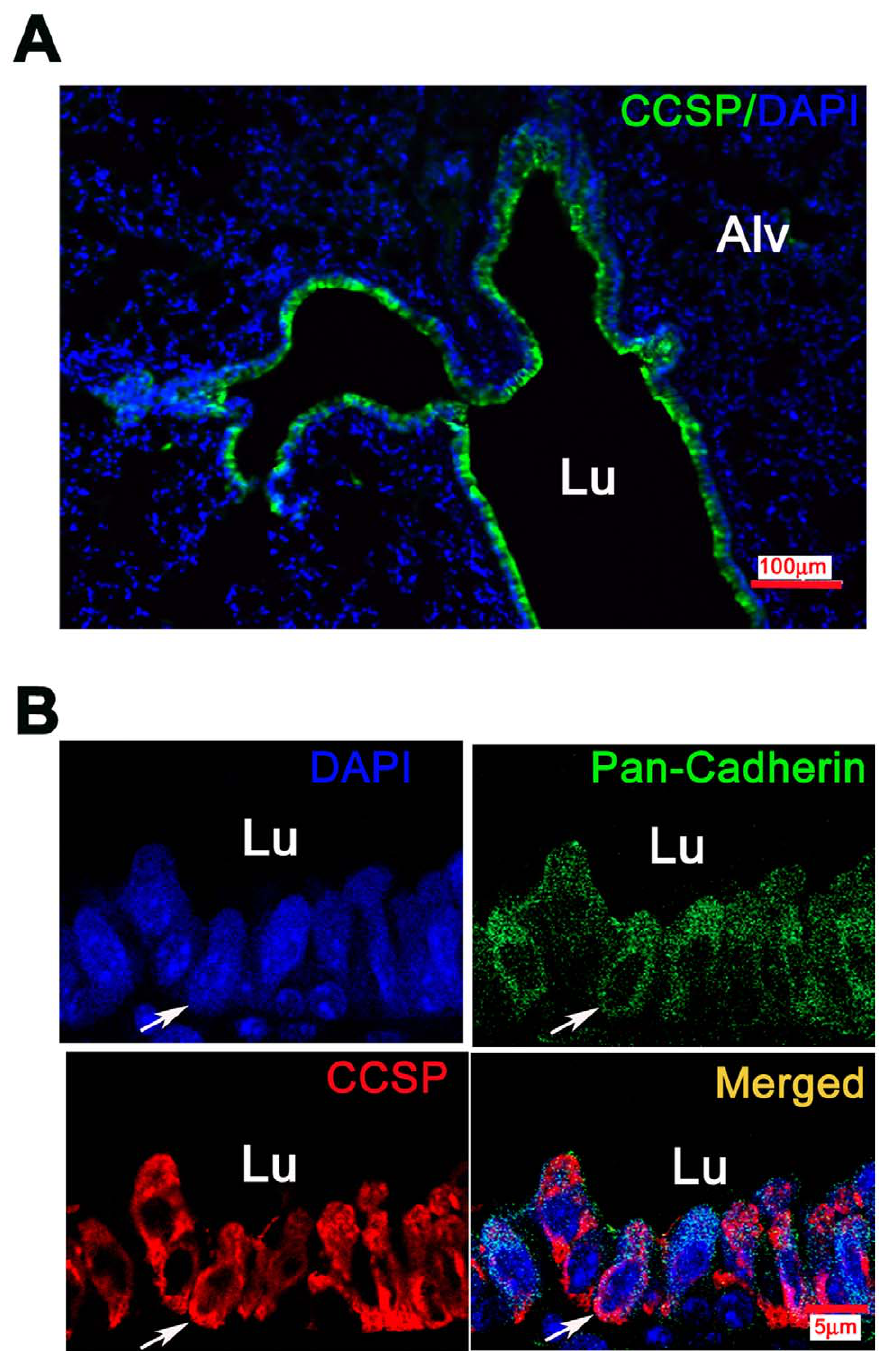
Figure 2. Membranous immunoreactiviy of CCSP in mouse airways. Photomicrographs of immunofluorescence in mouse lung tissue. A) Low power view of cells lining terminal bronchioles (TBs) that were intensely positive for CCSP (green fluorescence, Bar=100 m m,Alv=alveoli) B) High power views of co-expression (yellow) of pan-cadherin (green) and CCSP (red) in airway epithelium. Pan-cadherin expression is along the cell membranes, CCSP in the cytoplasm and cell membranes, mostly on outer surface. Bar=5 m m, Lu=lumen.